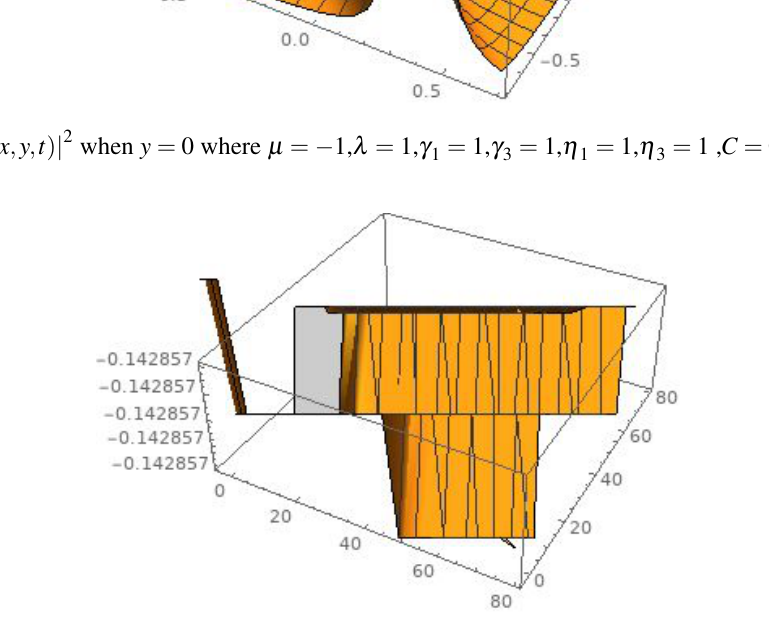
= 1, γ = 1, η = 1, η = 1 , C = 0 . (combined soliton 1 3 1 3